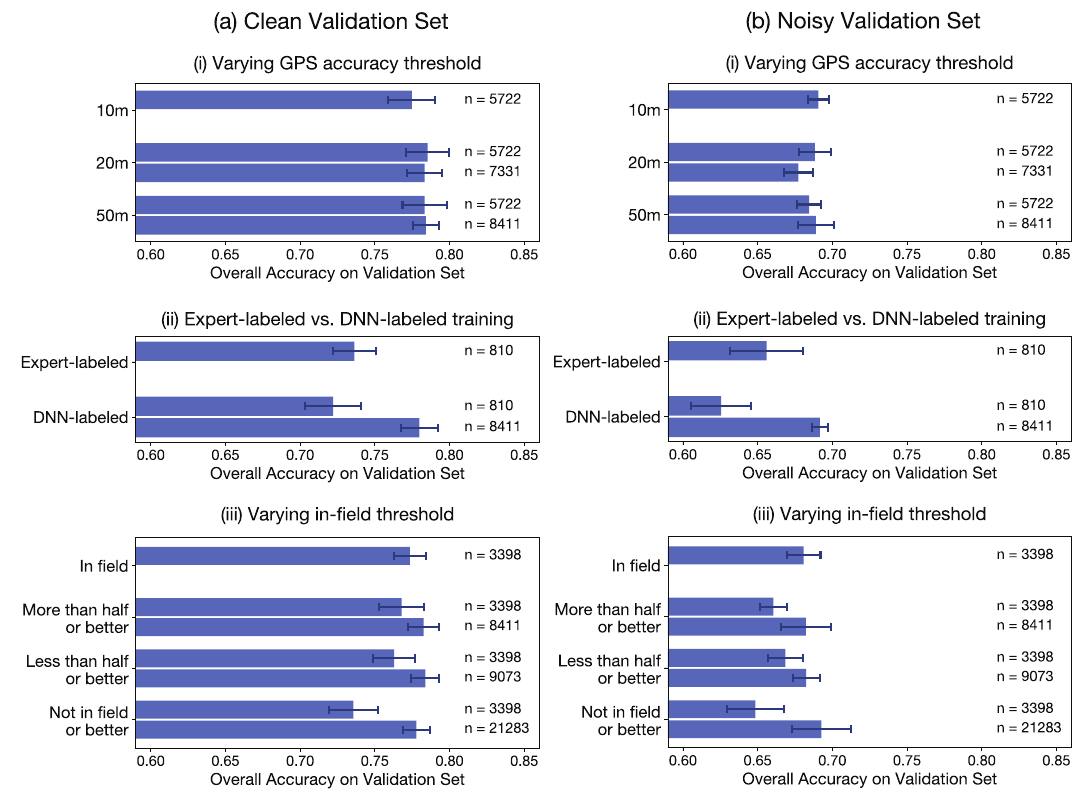
Figure 8. Sensitivity of classification results to dataset noise. The effect of increasing label error is shown along three dimensions of noise: GPS accuracy threshold (10 m, 20 m, 50 m), label source (expert vs. DNN), and in-field threshold (in field, more than half, less than half, and not in field) for ( a ) a clean validation set and ( b ) a noisy validation